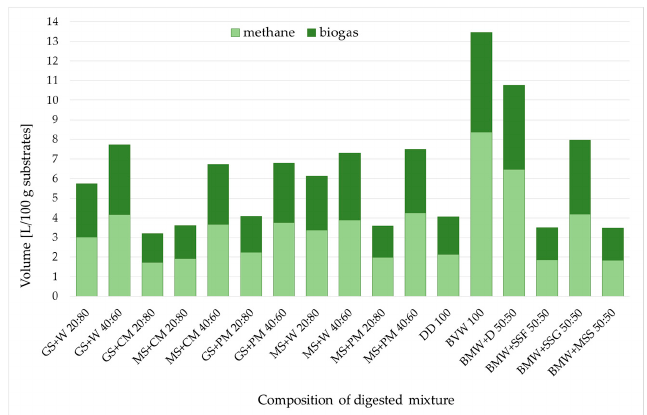
Figure 3. Average biogas and methane yields from biochemical methane potential (BMP) tests of different substrate mixtures. different substrate